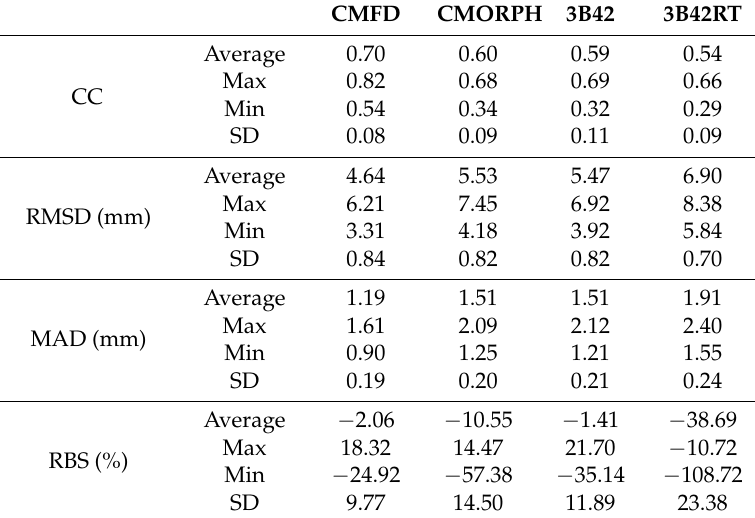
Table 3. Statistical metrics for detection of daily precipitation at 36 stations in Beijing using four satellite-derived precipitation products.